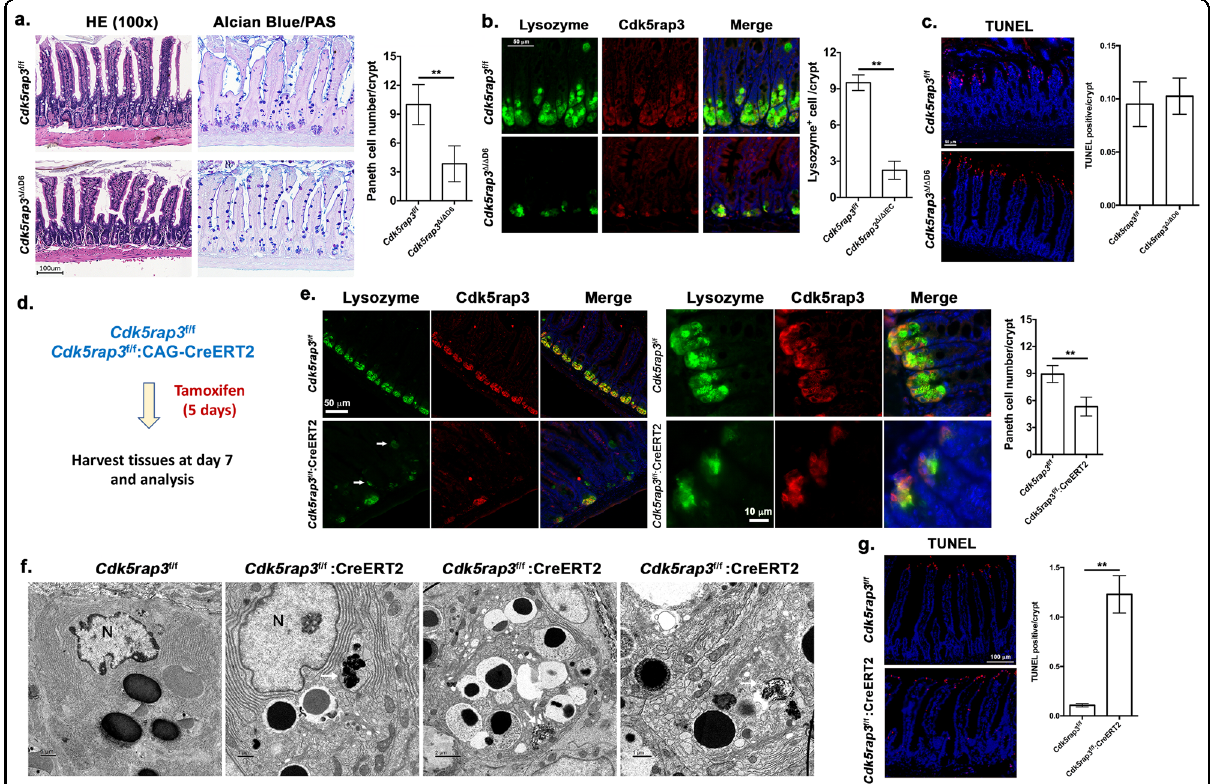
Fig. 3 Paneth cell-speci fi c deletion of Cdk5rap3 causes loss of Paneth cell. a H&E and Alcian blue/PAS staining of ileal sections of wild-type and Cdk5rap3 Paneth cell-speci fi c Cdk5rap3 KO mice ( Cdk5rap3 Δ / Δ D6 ). The number of Paneth cells per crypt was scored. ** p < 0.01. ( n = 4 mice